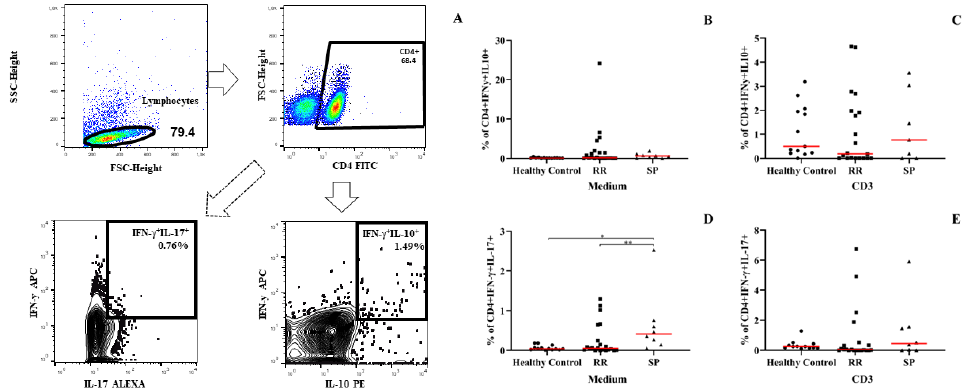
Figure 7. Flow cytometry evaluation of double CD4+ T cells producing cytokines in patients with multiple sclerosis. ( A ) Schematic representation of the gating strategy for the acquisition of flow cytometry data for the culture of PMBCs, with the gates proposals for CD4 + IFN- γ + IL-10 + lymphocytes and CD4 + IFN γ + IL17 + . ( B ) The percentage of CD4 + IFN γ + IL10 + T lymphocytes in the cells in the absence of stimulation. ( C ) The percentage of CD4 + IFN γ + IL10 + lymphocytes in cells stimulated with anti-CD3. ( D ) The percentage of CD4 + IFN γ + IL17 + T lymphocytes in cells without stimulation. ( E ) The percentage of CD4 + IFN γ + IL17 + T lymphocytes in anti-CD3-stimulated cells. Statistical analysis was performed using the Kruskal–Wallis test with Dunn’s post-test, where * and ** represents p < 0.05.